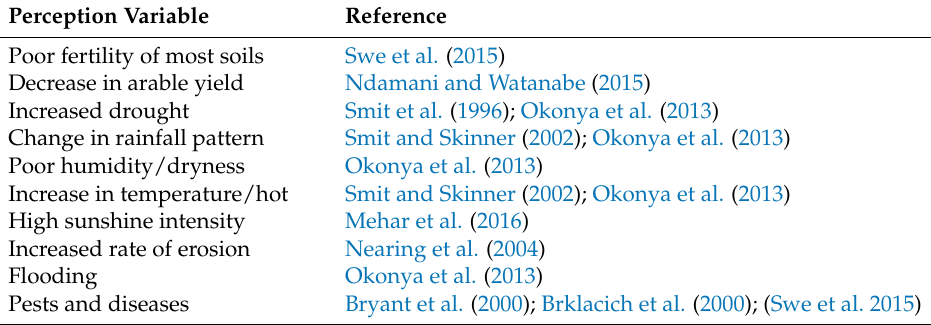
Table 2. Climate change perception variables selected for principal component analysis (PCA) based on literature review.